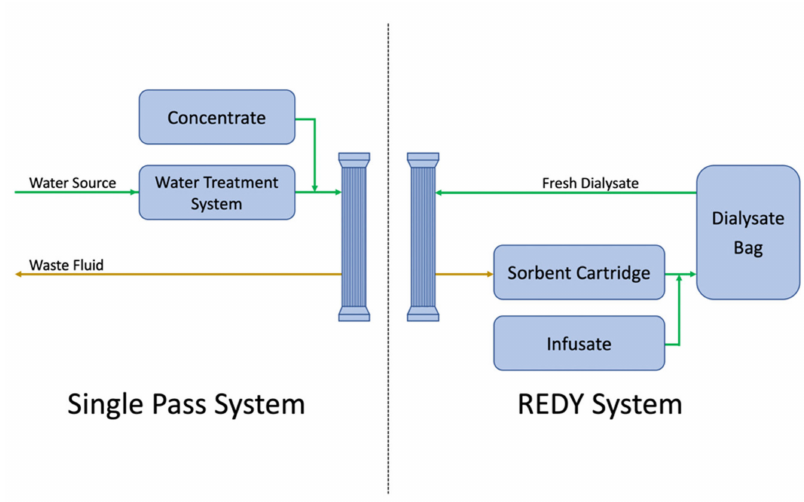
Figure 2. Comparison of the single pass system and the REDY system: dialysis with the single pass system requires a steady water source and used dialysate is abandoned after dialysis. In comparison, the REDY system regenerates fresh dialysate with sorbent